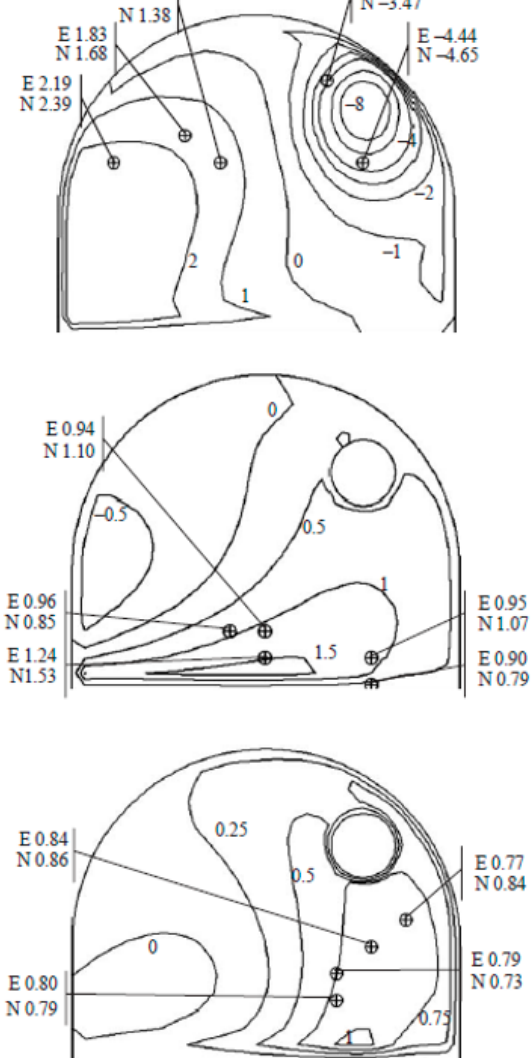
Figure 2. Comparison of numerical and experimental results of streamwise velocities (m/s) for validation of CFD models [11]. (Reprinted with permission from ref. [11]. Copyright 2005 Elsevier Ltd.).